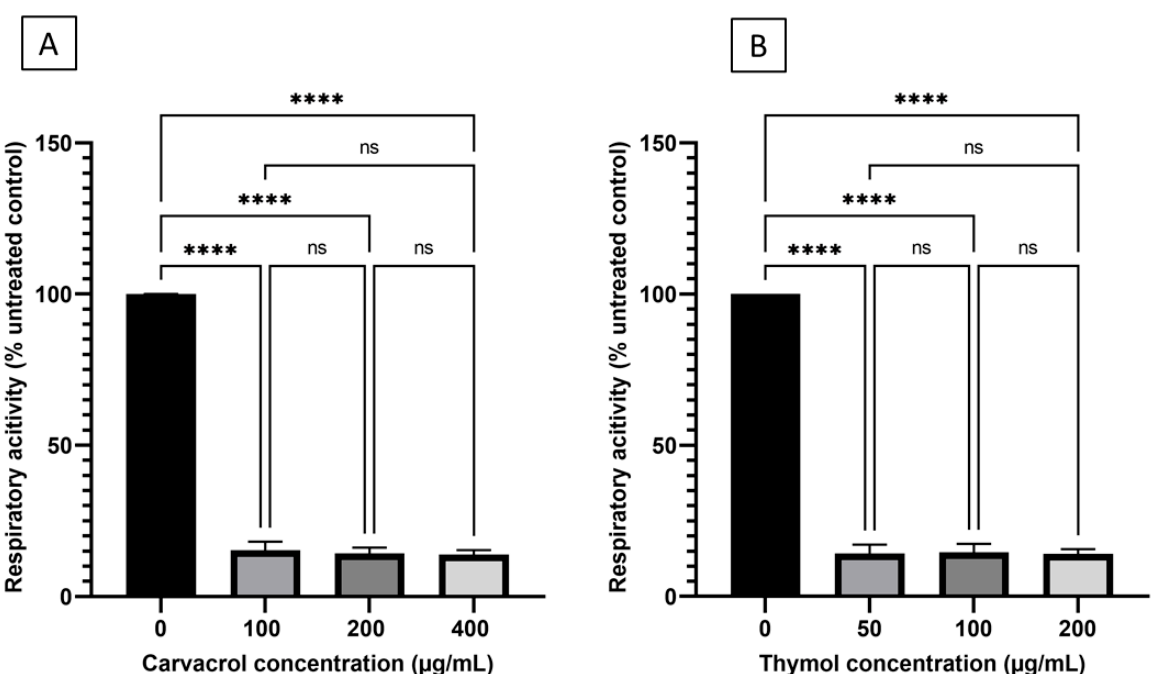
Figure 8. Changes in the respiratory activity of desiccation-adapted Salmonella Tennessee E2007000304 after treatment with different concentrations of carvacrol (panel ( A )) or thymol (panel ( B )) for 22 h at 37 °C. Each data point represents mean ± standard deviation. Asterisks (****) denote significant difference at p < 0.0001. “ns” denotes non-significant (i.e., p > 0.05)